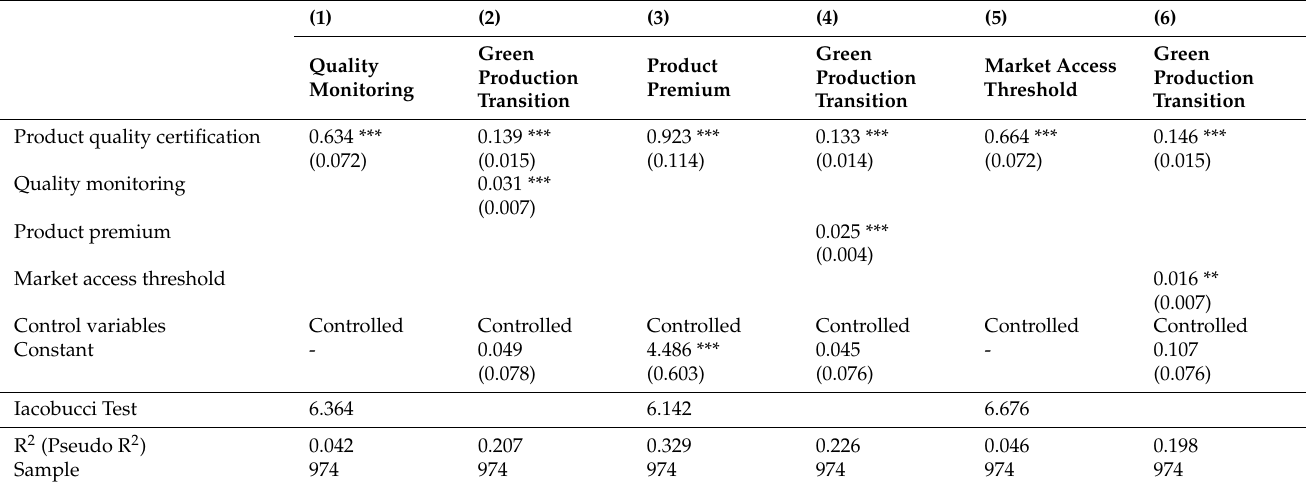
Table 6. Regression results for the channel